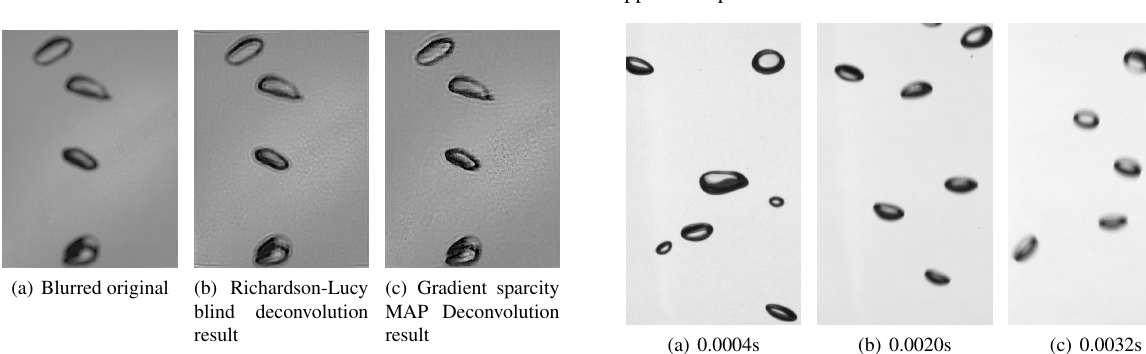
Figure 4: Bubble images acquired with different integration times with automatic gain